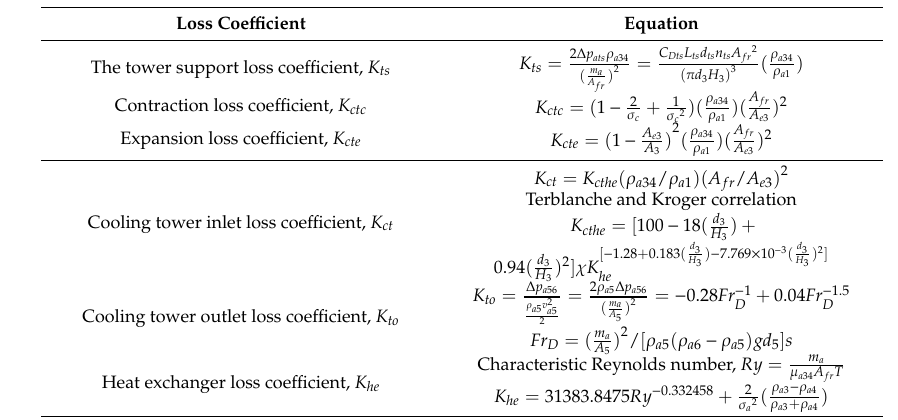
Table 2. The coe ffi cients of loss of air in NDDCT